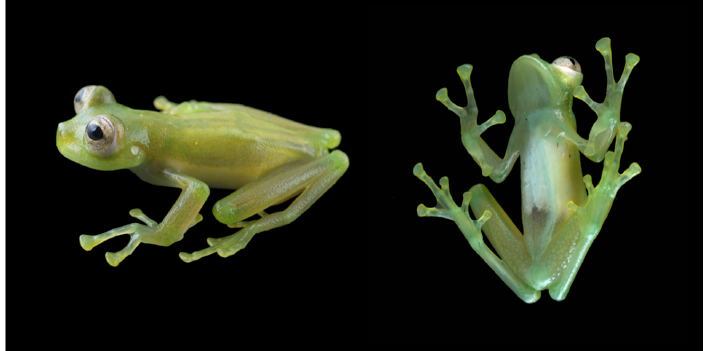
Figure 158. Nymphargus humboldti sp. nov. in life. Male from Río Yana Challuwa, Pastaza province, Ecuador, QCAZ 47514, paratype. Photos by Luis A. Coloma.